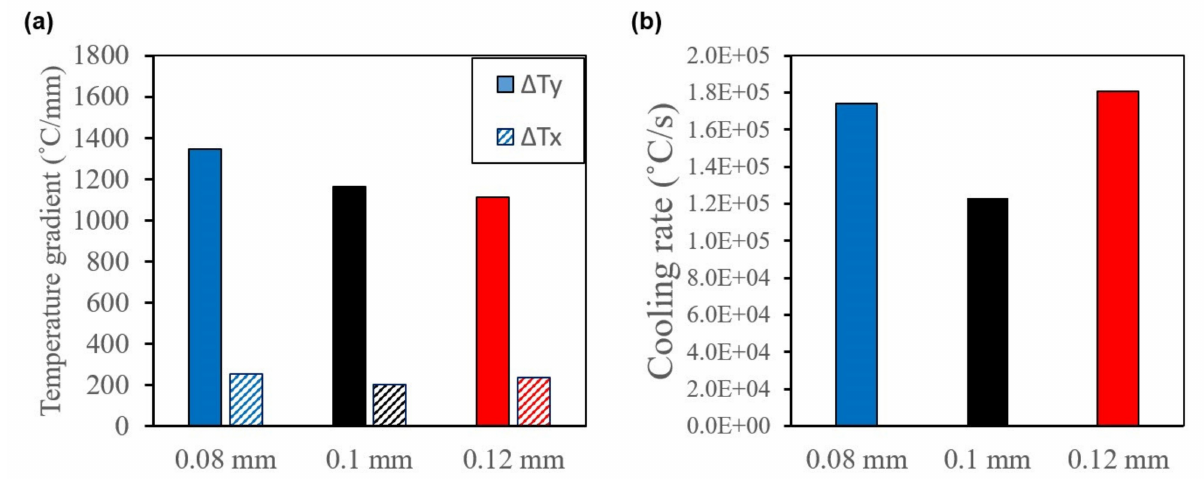
Figure 32. Effect of hatch spacing on ( a ) temperature gradient and ( b ) CR at 650 mm/s and 0.12 mm.